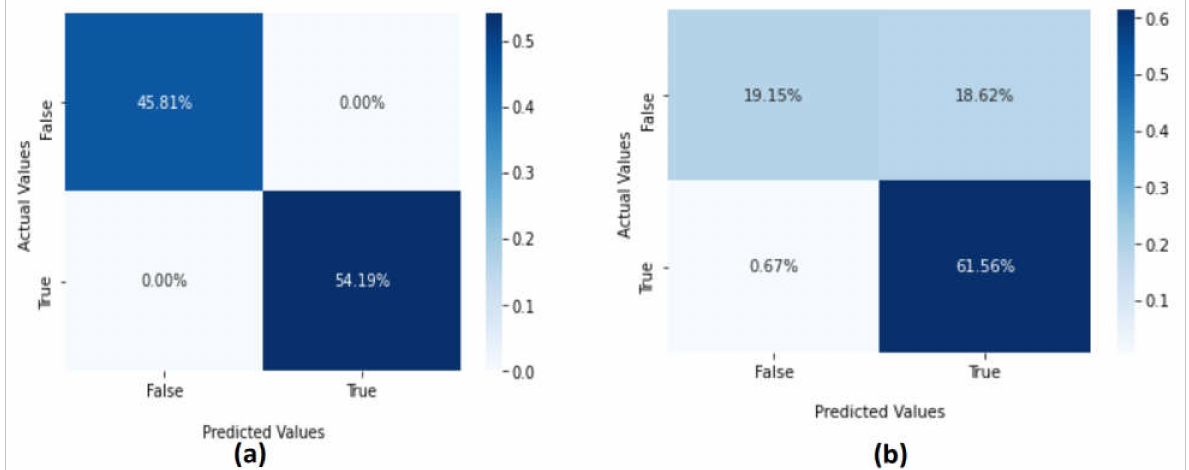
Figure 10. The confusion metrics of the SVM method using the ( a ) CICAndMal2017 and ( b ) Drebin